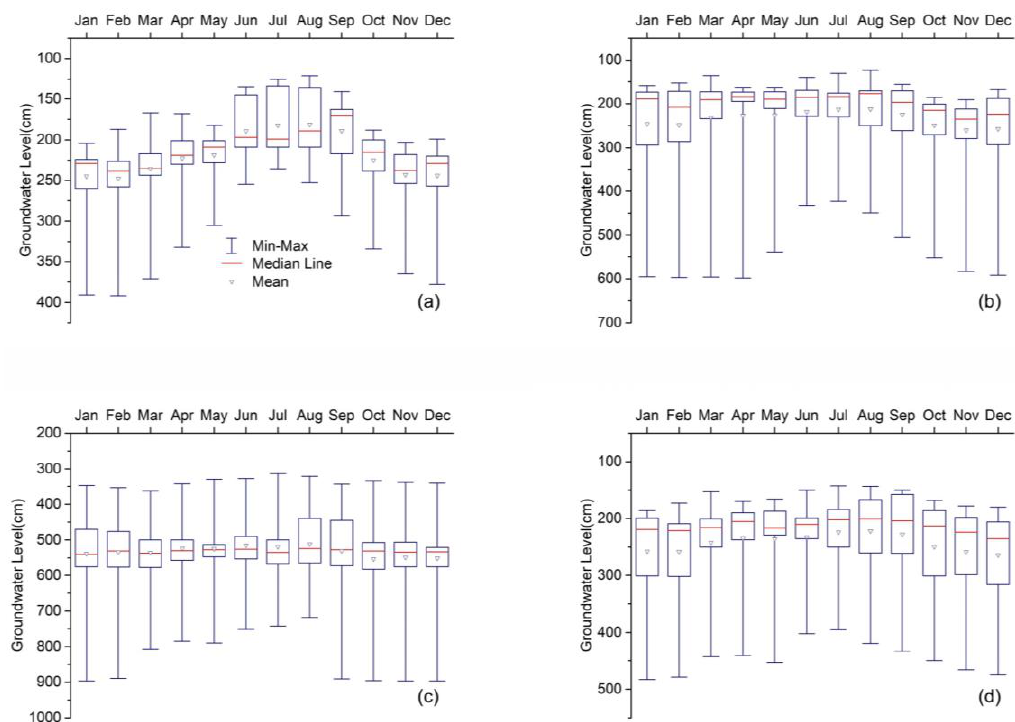
Figure 7. Statistical analysis (box-plot) of the monthly average groundwater level from 1999 to 2017 in Nukus ( a ), Karauzyak ( b ), Muynak ( c ), Kungrad ( d ).